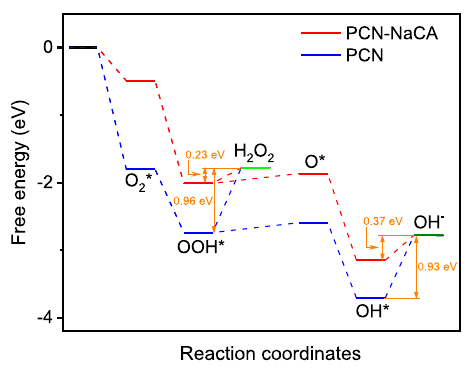
Fig. 8 Free energy diagrams of ORR (oxygen reduction reaction) steps on PCN-NaCA (red lines) and PCN (blue lines). PCN polymeric carbon nitride, PCN-NaCA-2 polymeric carbon nitride with sodium cyanaminate